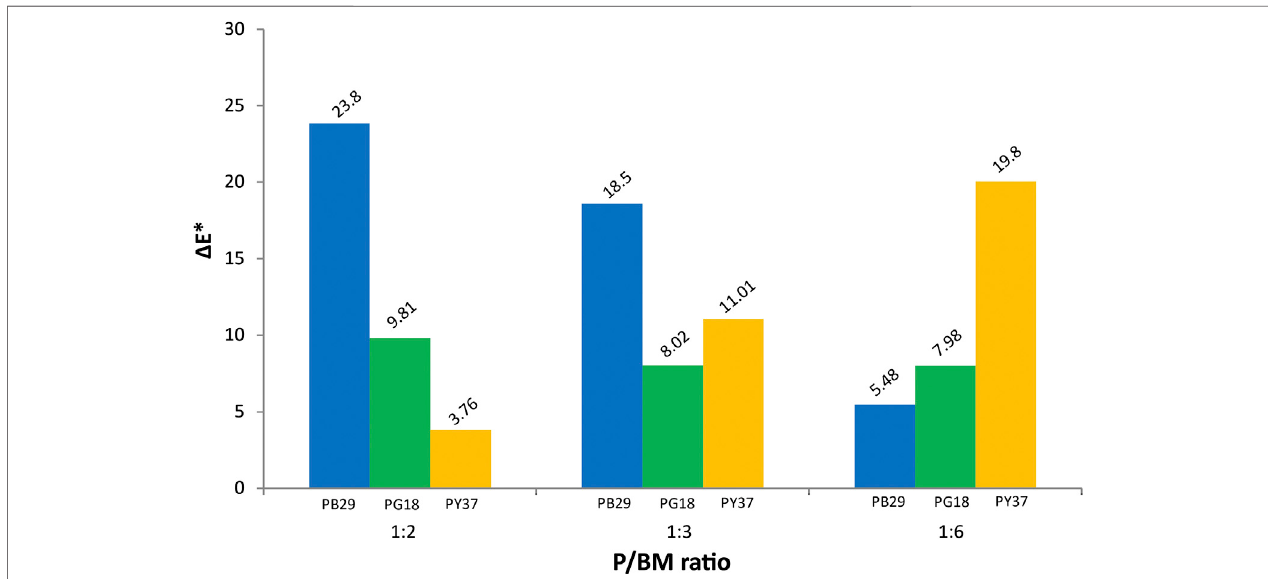
FIGURE 4 | Photodegradation kinetics evaluated by Δ E* changes of alkyd paints over UV exposure.